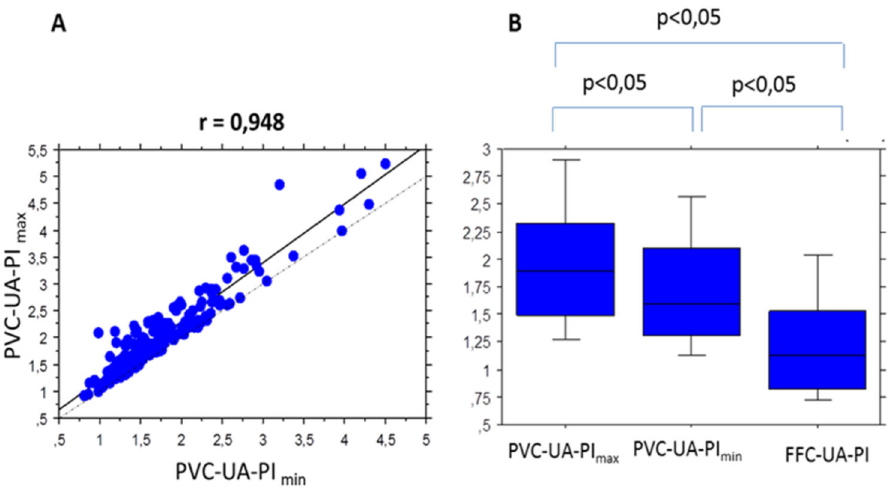
Figure 1. A: Correlation between the two UA-PIs measured at the perivesical (PVC) segment. The larger UA-PI value of the pair was designated PVC-UA-PI and the smaller, PVC-UA-PI . The dotted line depicts the line of equality. B: Comparison max min between the UA-PI measured at the PVC segment and in the free-floating cord (FFC). doi: